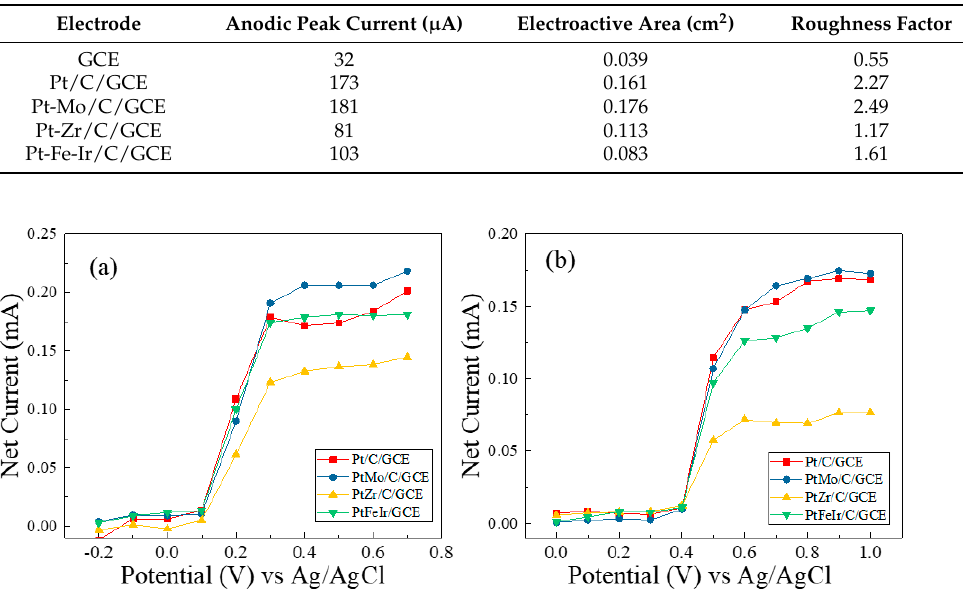
mM AA; ( b ) 10 mM DA for the Pt/C/GCE, Pt-Mo/C/GCE, Pt-Zr/C/GCE, and Pt-Fe-Ir/C/GCE.